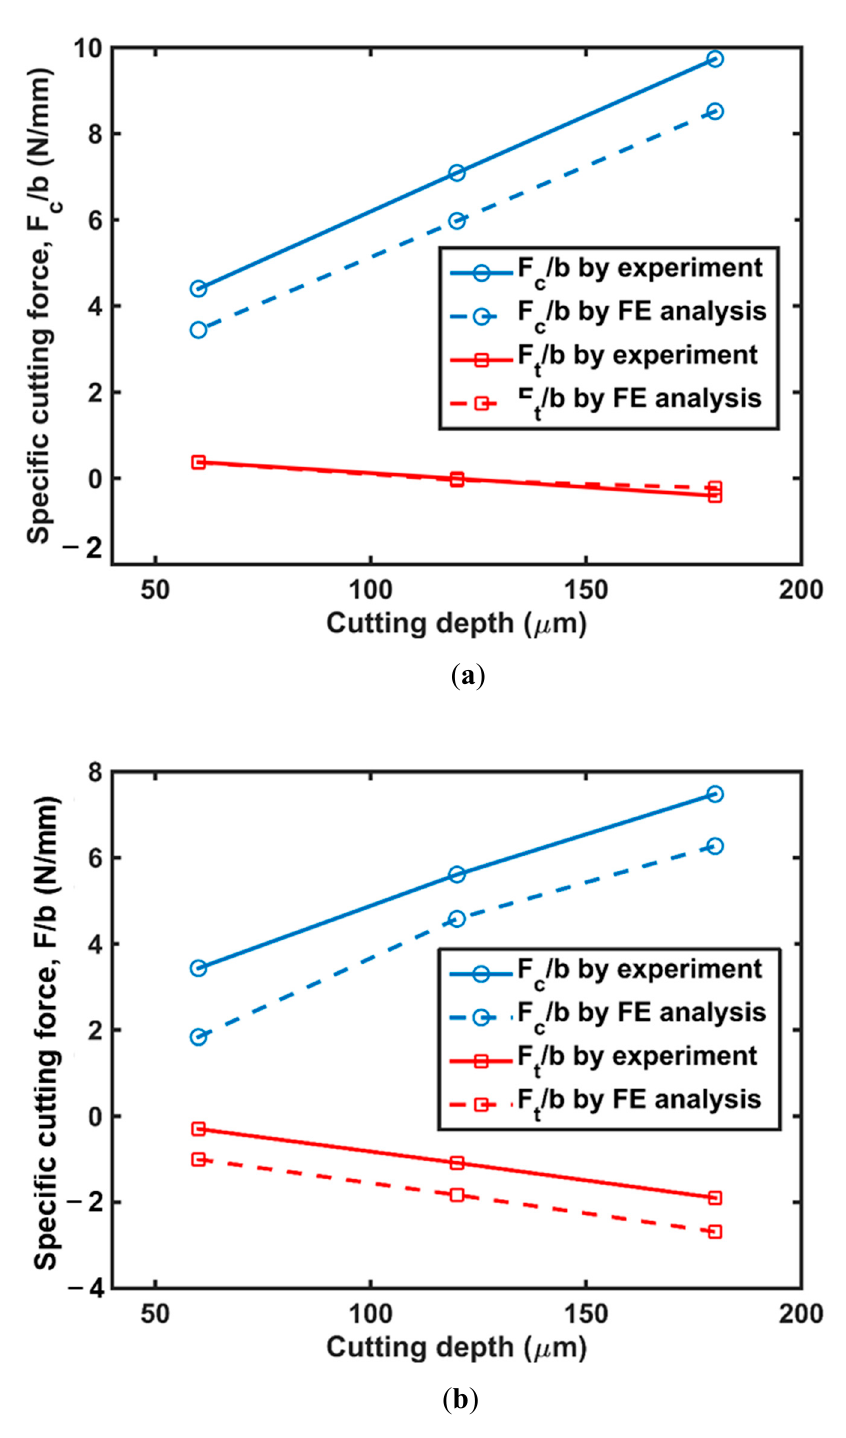
Figure 5. Comparison of cutting force obtained by experiment and simulation of HDPE with a rake angle of ( a ) 15° and ( b ) 30°.